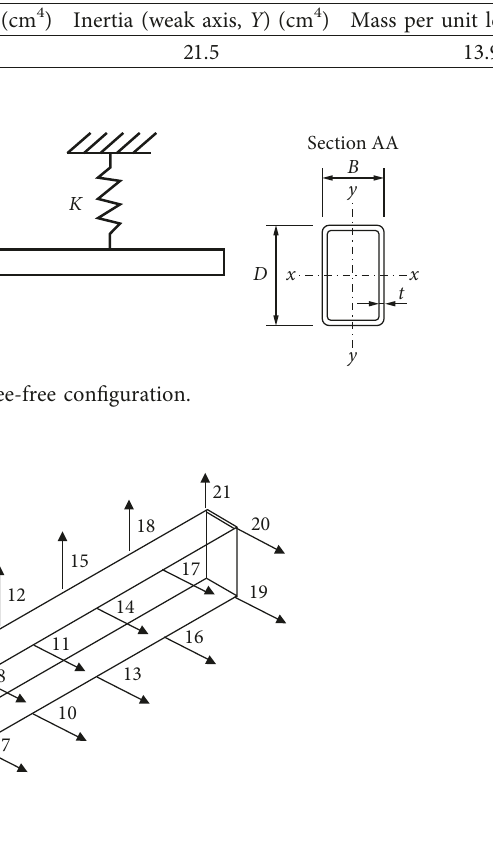
Table 1: Mechanical and material properties of the beam.